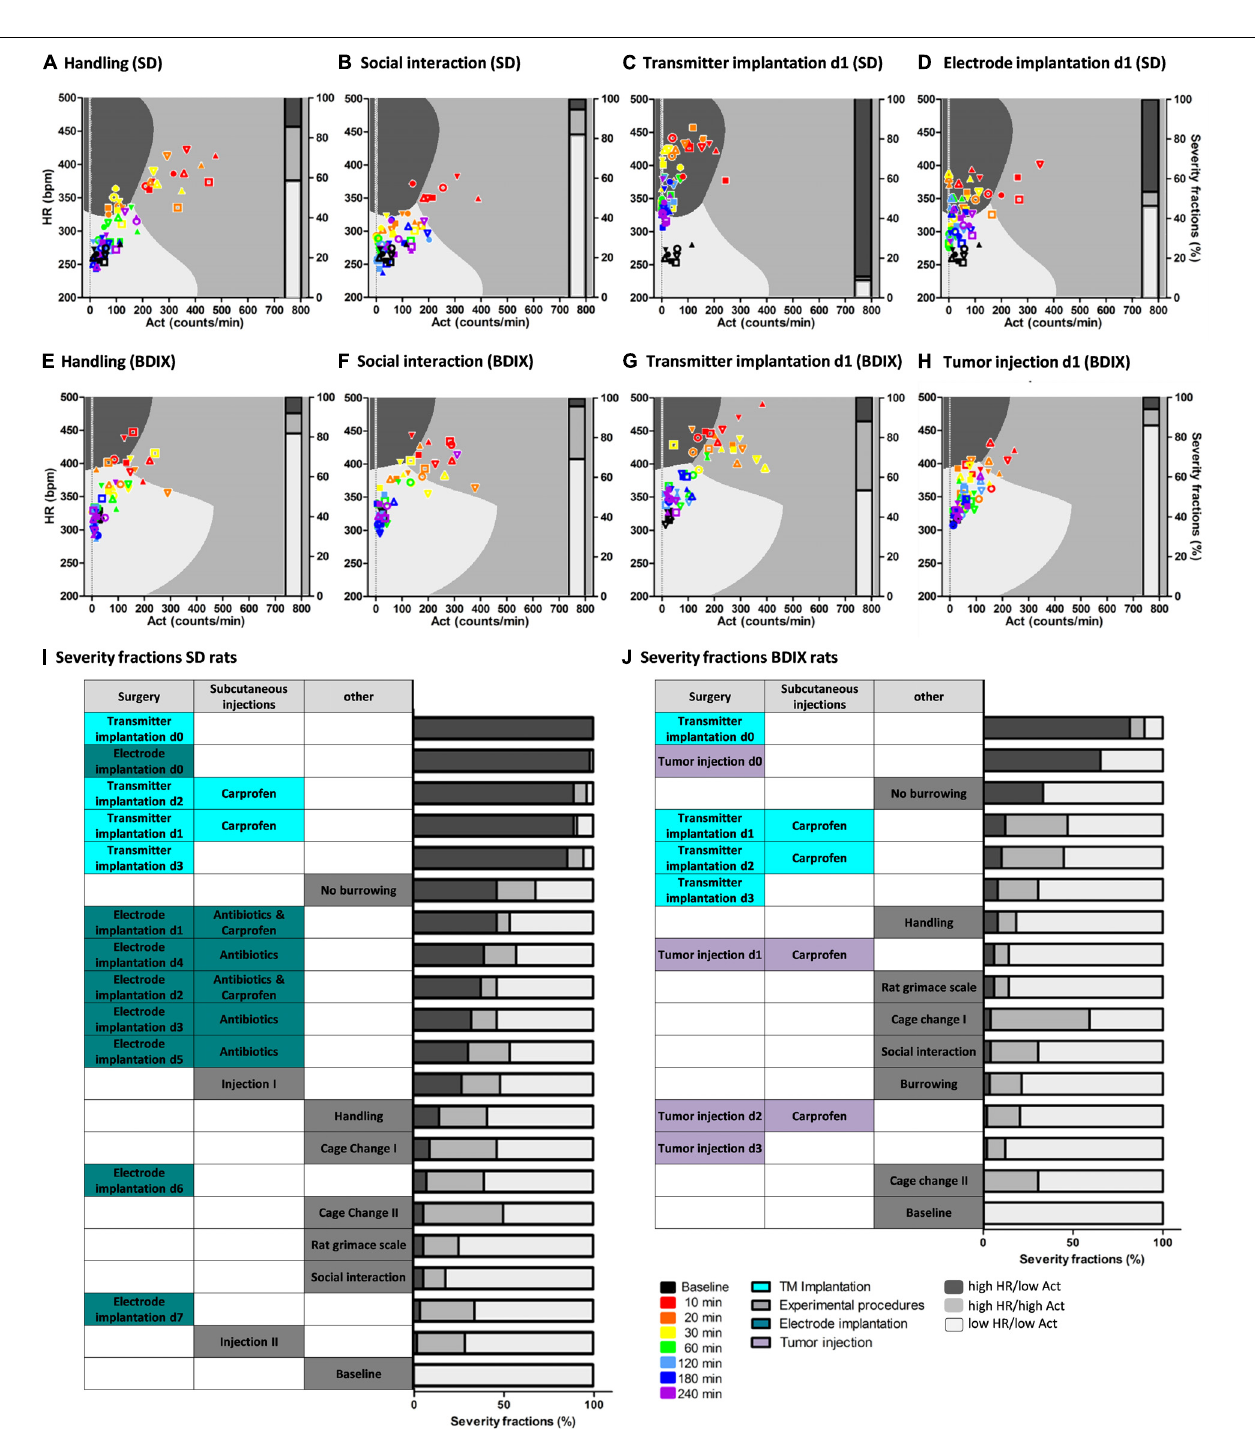
FIGURE 3 | Evaluation of SVM as tool to classify severity. Exemplarily validation data plotted on SVM decision boundaries (A–H) : handling [ (A) SD rats, (E) BDIX rats], social interaction [ (B) SD rats, (F) BDIX rats], transmitter implantation d1 [ (C) SD rats, (G) BDIX rats], electrode implantation d1 in SD rats (D) , and tumor injection in BDIX rats (H) . HR (HR; bpm) is shown as mean, and activity (Act; counts/min) is shown as sum over 10 min starting at the indicated time points (color coded) after the experimental procedure. Symbols indicate different individual animals. Three classes were identified by SVM: high HR/low Act (dark gray), high HR/high Act (midgray), low HR/low Act (light gray). Bars indicate fractions of data points allocated to different classes. Ranking of all experimental procedures according to the fraction of data points allocated to the high HR/low Act class [ (I) SD rats, (J) BDIX rats].